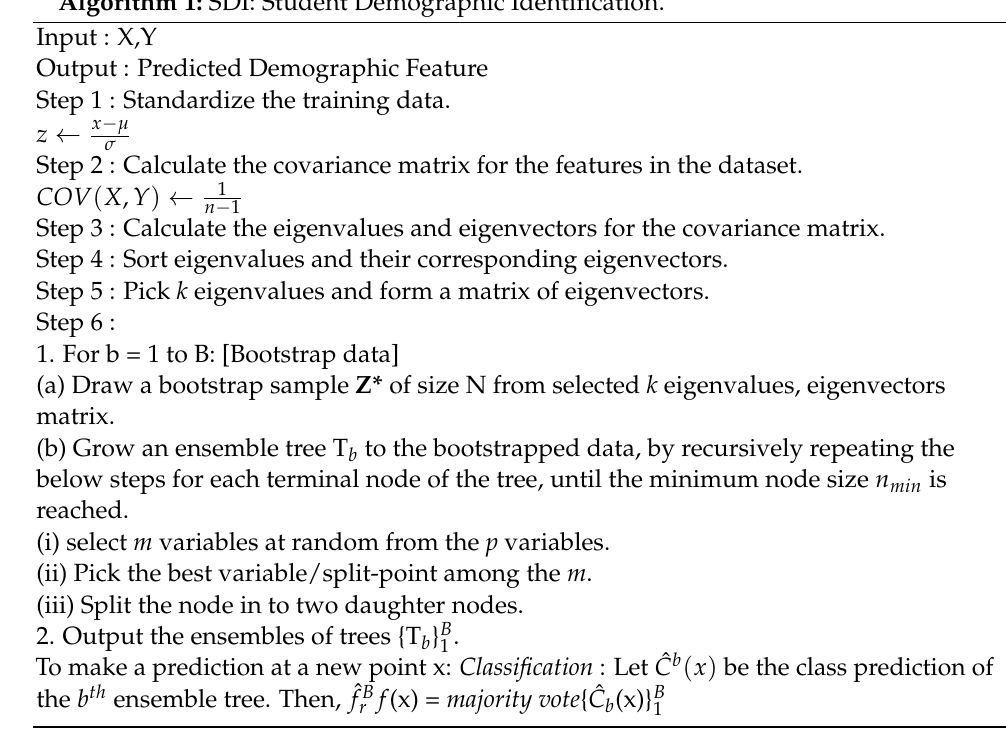
Algorithm 1: SDI: Student Demographic Identification.